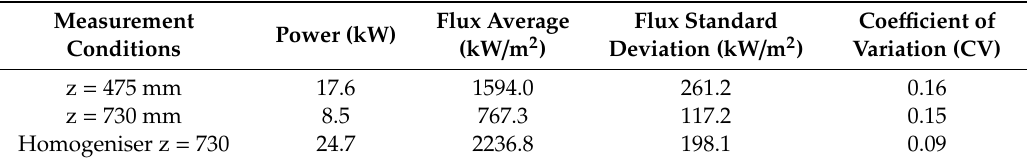
Table 1. Statistical results for the three sets of experimental data reported in this work: without homogeniser (at z = 475 mm and z = 730 mm) and with homogeniser (at z = 730